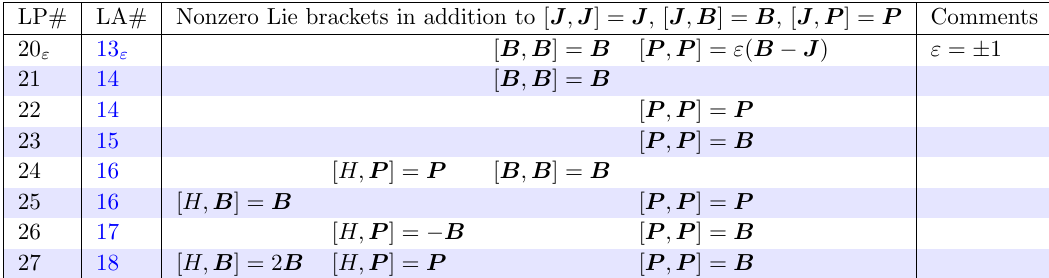
Table 7 . Lie pairs for kinematical Lie algebras unique to D =